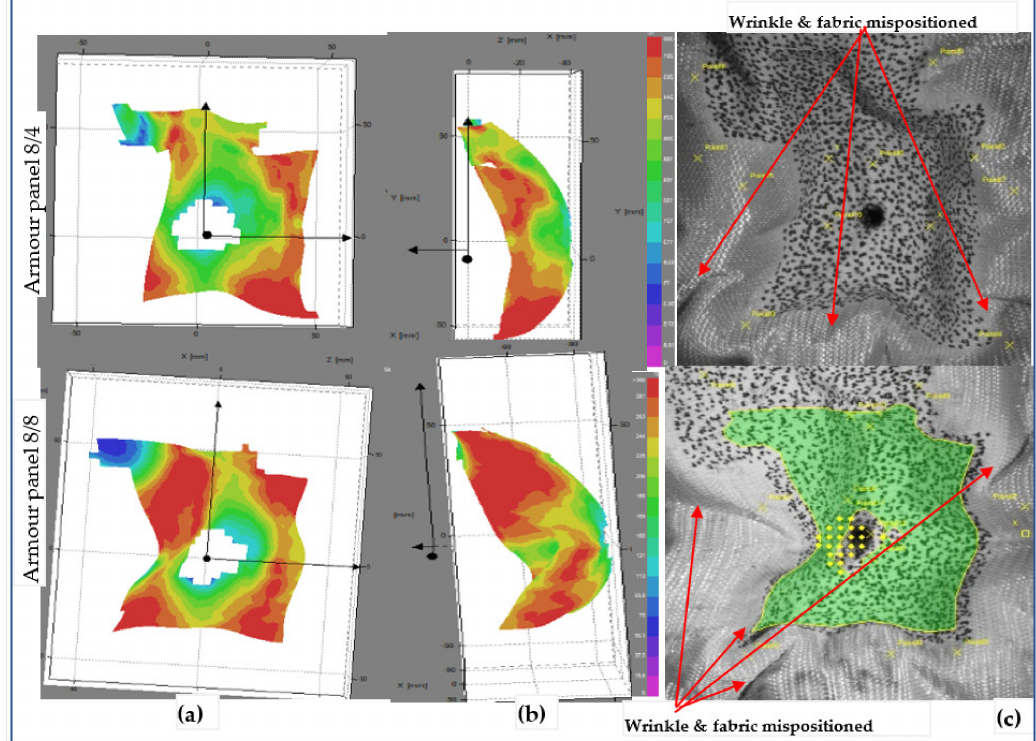
Figure 18. Surface displacement of frontal armour panel at impact times of 3.6 ms ( a , b ), 3D frontal and side views of stereoscopic images, respectively, and ( c ) frontal panel images at shot point